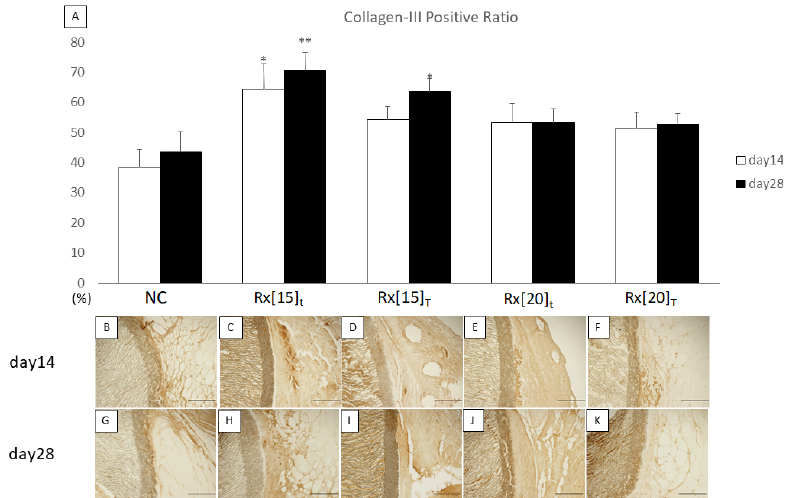
Figure 7. Col-III stained sections after implantation of radiation-crosslinked hydrogel RXgel-coated expanded polytetrafluoroethylene ePTFE vascular grafts: ( A ) Expression ratio of Col-III was analyzed by Col-III staining. The significance compared to non-coated ePTFE on the same day is shown by asterisks (* p < 0.05, ** p < 0.005); ( B – K ) Col-III staining of 5- µ m sections on days 14 and 28 after implantation of each RXgel-coated ePTFE graft. In each picture, the outer surface of ePTFE graft is in the center and at the right side of the graft wall. Col-III positive areas are shown in dark brown. Each scale bar indicates 100 µ